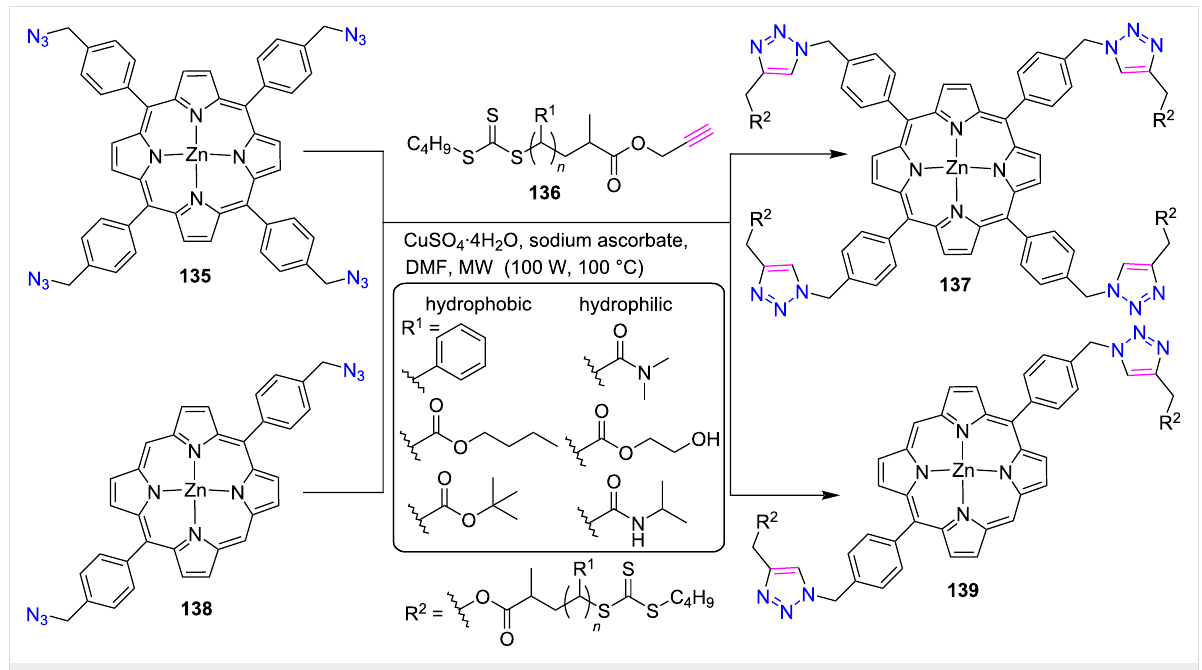
Scheme 28: Synthesis of meso - triazole-linked porphyrin-polymer conjugates 137 and 139